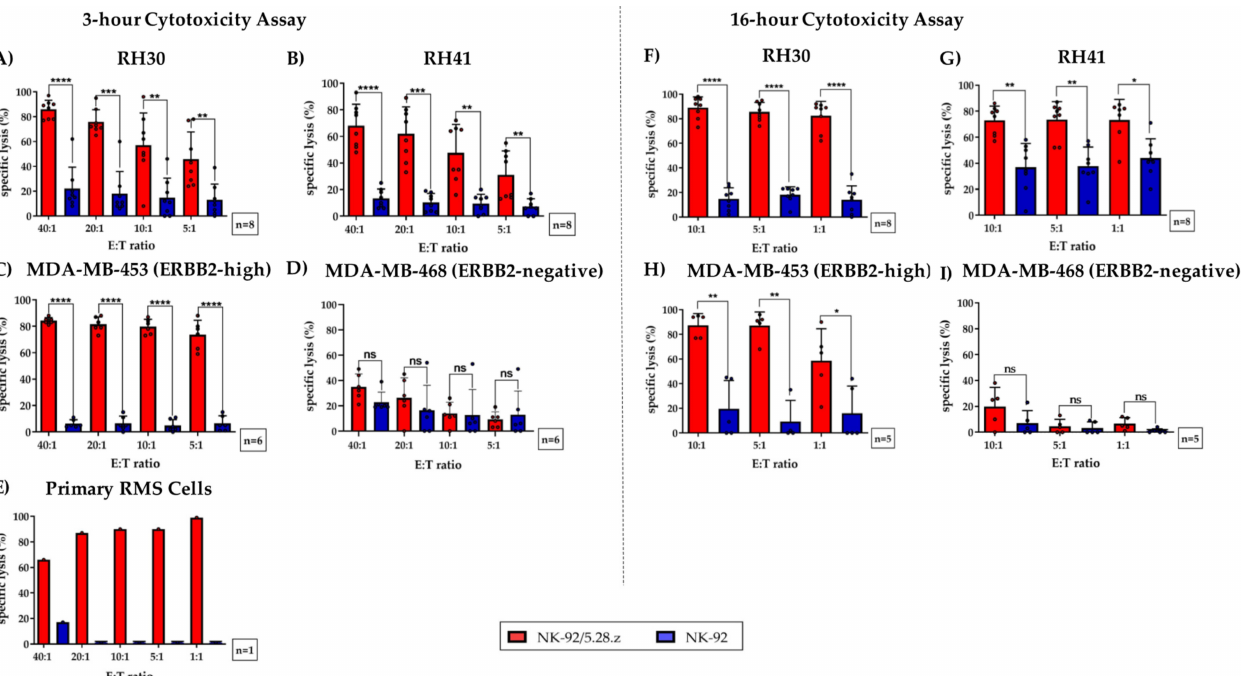
Figure 3. Specific cytotoxicity of NK-92/5.28.z cells against aRMS cell lines growing in suspension or as tumor cell monolayers. NK-92/5.28.z cells were compared with unmodified parental NK-92 cells in a 3-h cytotoxicity assay against cell suspensions of ( A ) RH30 cells, ( B ) RH41 cells, ( E ) primary aRMS cells, ( C ) MDA-MB-453 cells (which served as a positive control), and ( D ) MDA-MB-468 cells (which were used as a negative control). The effector-to-target (E:T) ratios ranged from 40:1 to 5:1 or from 40:1 to 1:1 (in primary RMS cells). Tumor cell lysis was ERBB2-specific and significantly increased when NK-92/5.28.z cells were used, even at low E:T ratios. In a 16-h cytotoxicity assay, the killing capacity of NK-92/5.28.z cells against monolayers of ( F ) RH30, ( G ) RH41, ( H ) MDA-MB-453, and ( I ) MDA-MB-468 tumor cells was assessed in comparison to that of parental NK-92 cells by a Celigo cell cytometer. ARMS monolayers were lysed to a significantly greater extent by NK-92/5.28.z cells than by unmodified parental NK-92 cells. Differences were considered significant for p < 0.05 (*), p < 0.01 (**), p < 0.005 (***), and p < 0.0001 (****), or not significant